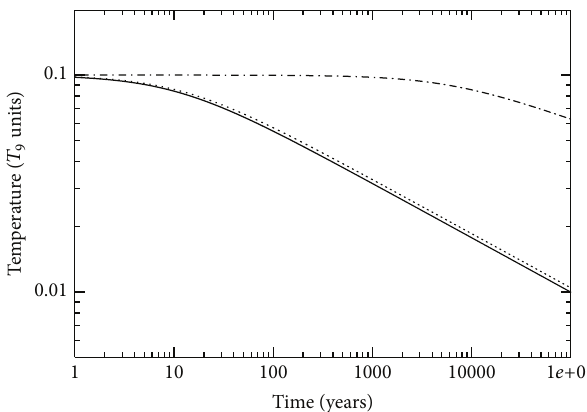
Figure 7: The cooling behavior of neutron star with core as neutron matter and degenerate quark matter. The dotted line represents the Fermi liquid result; the solid line gives the result including non- Fermi liquid correction. The dash-dotted line gives the cooling behavior of the neutron star core made up of purely neutron